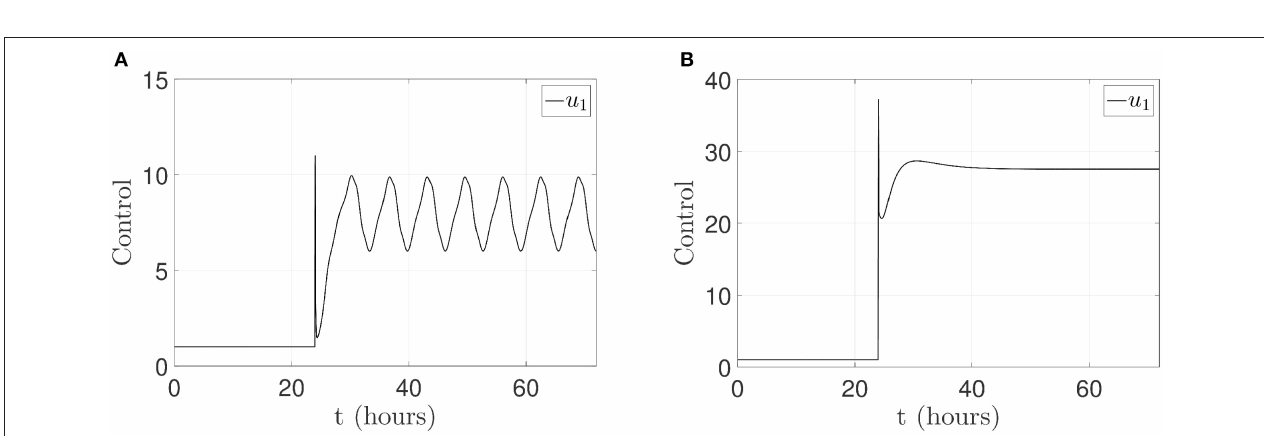
FIGURE 8 | Control signal u 1 ( t ) applied in p14ARF. (A) Case 1: control action to achieve an oscillatory pattern under gamma-radiation. (B) Case 2: control action to achieve an increased expression of p53 response.